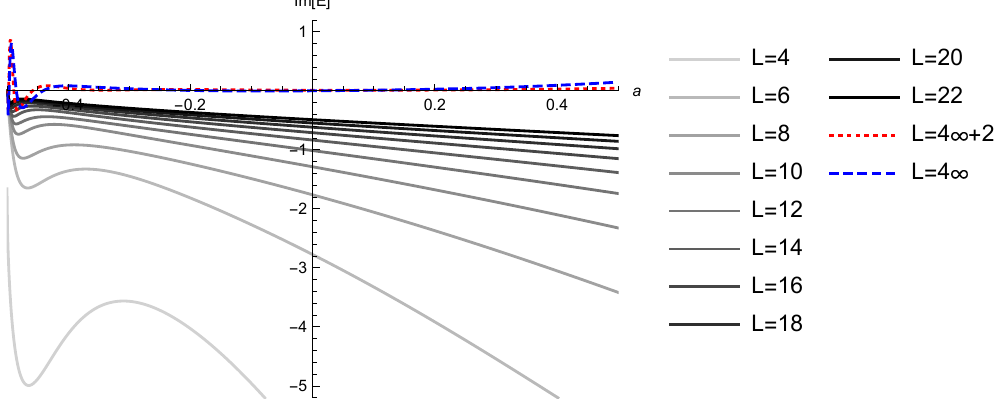
Figure 11 . Plots of the imaginary part of the energy E (2.15) for the “ghost brane” solution Φ G at the truncation level L . The dotted and dashed lines are extrapolations to L = 4 k + 2 ( k → ∞ ) and L = 4 k ( k → ∞ ), respectively. The horizontal axis denotes the value of the parameter a .